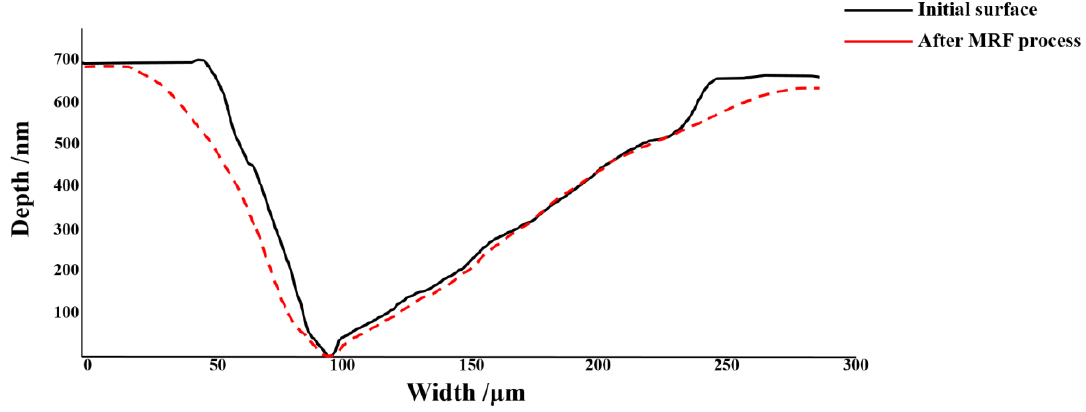
Figure 15. The section curve of large-scale defects before and after MRF process.